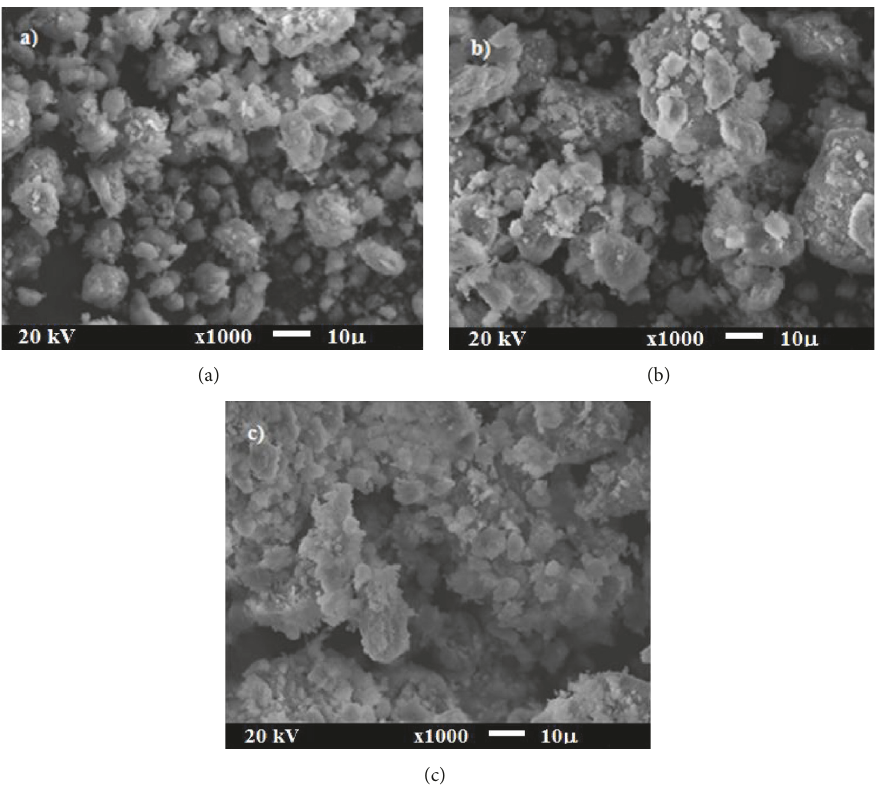
Figure 2: Scanning Electron Microscopic images of (a) MMT, (b) AMMT, and (c) IMMT.